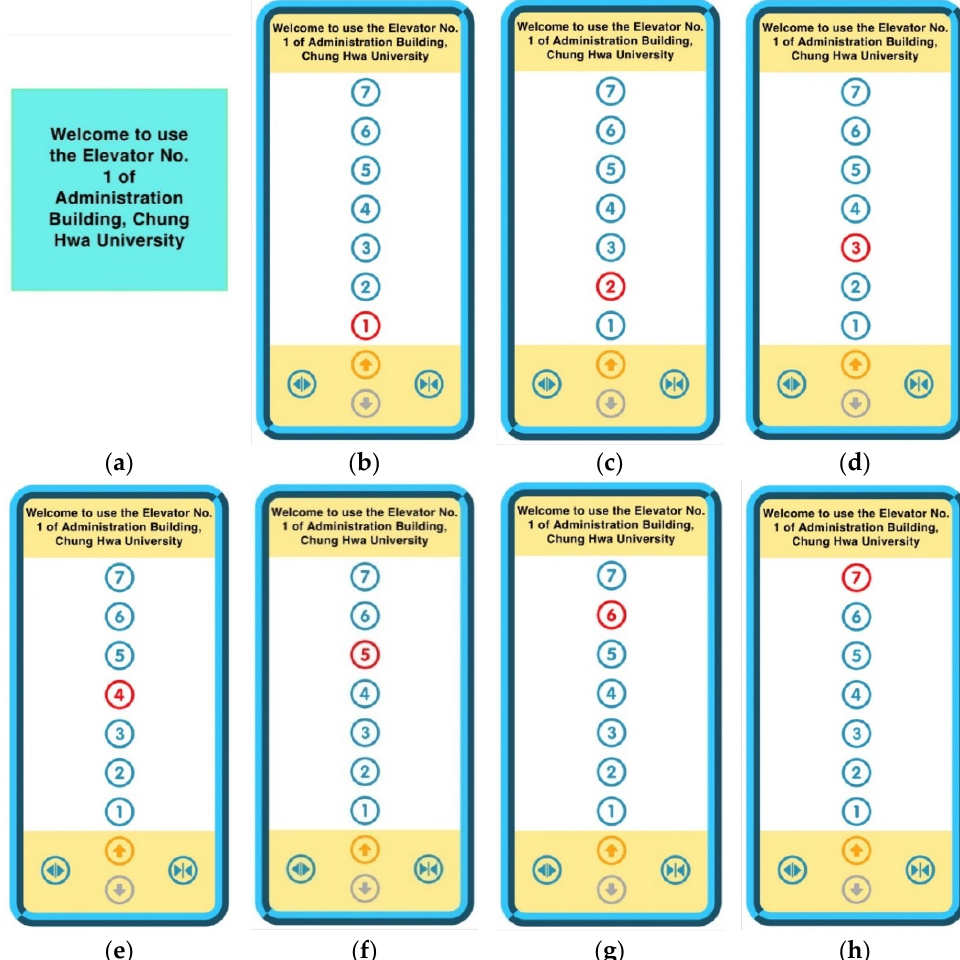
Figure A6. Synchronized images of elevator control software app. ( a ) Welcome screen of elevator control software app; ( b ) synchronized image of activation of 1F button; ( c ) synchronized image of activation of 2F button; ( d ) synchronized image of activation of 3F button; ( e ) synchronized image of activation of 4F button; ( f ) synchronized image of activation of 5F button; ( g ) synchronized image of activation of 6F button; ( h ) synchronized image of activation of 7F button.